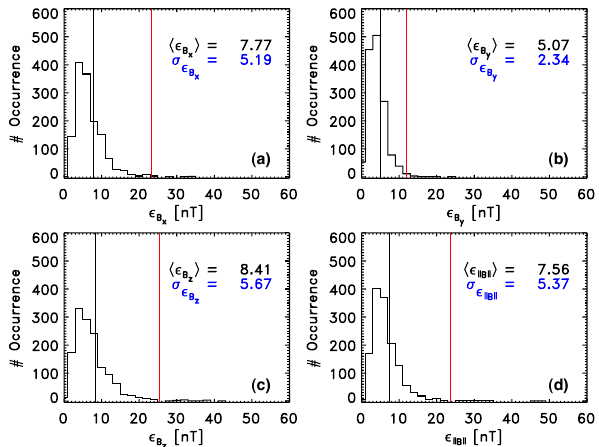
Fig. 3. Comparison of magnetic field vectors values estimated by the geomagnetic model IGRF-11 + Tsy04 with values measured by the FGM instrument. Panels (a) , (b) , (c) and (d) refer to the x , y , z vector components and overall magnitude. Black vertical lines de- pict, respectively, the mean value of distributions displayed in each panel. Red vertical lines set the limit of rejected cases.